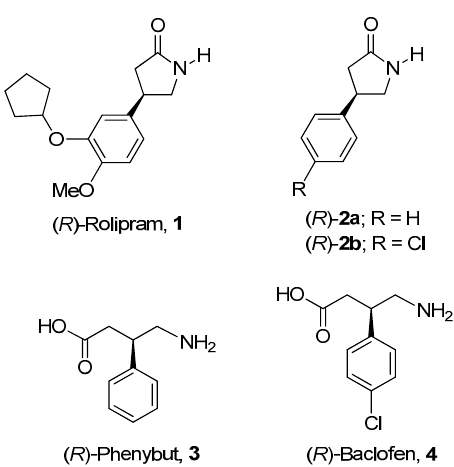
Figure 1. Structures of γ -lactams and GABA derivatives used as pharmaceuticals.